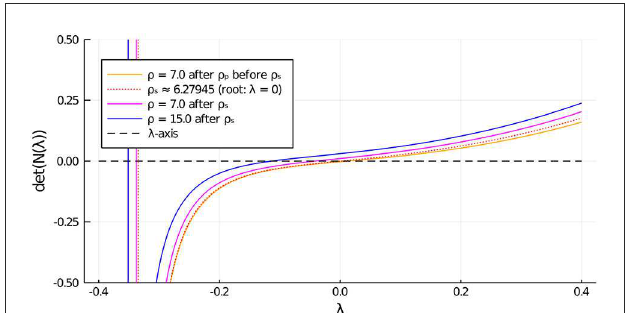
FIGURE9 Zero-crossings of det( N ( λ )) 0, as defined in Equation (3.18), = determine the linear stability properties of an asymmetric steady-state solution with two cells. On the range ρ p < ρ < ρ s , before the secondary fold point along the asymmetric branch, we observe that λ > 0. This implies that the subcritical portion of the asymmetric steady-state branch between the pitchfork point and the fold point is unstable. Further along past the fold point the asymmetric branch regains stability.